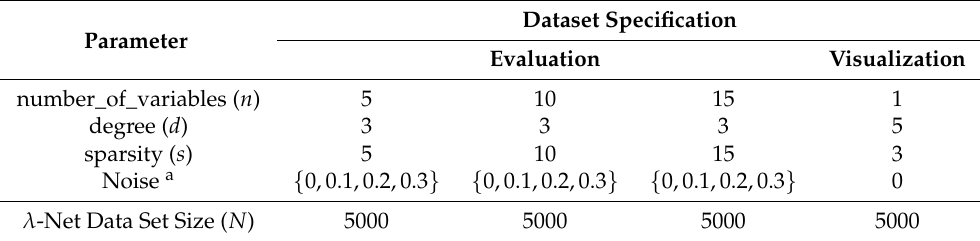
Table 1. Dataset specifications for λ -Net